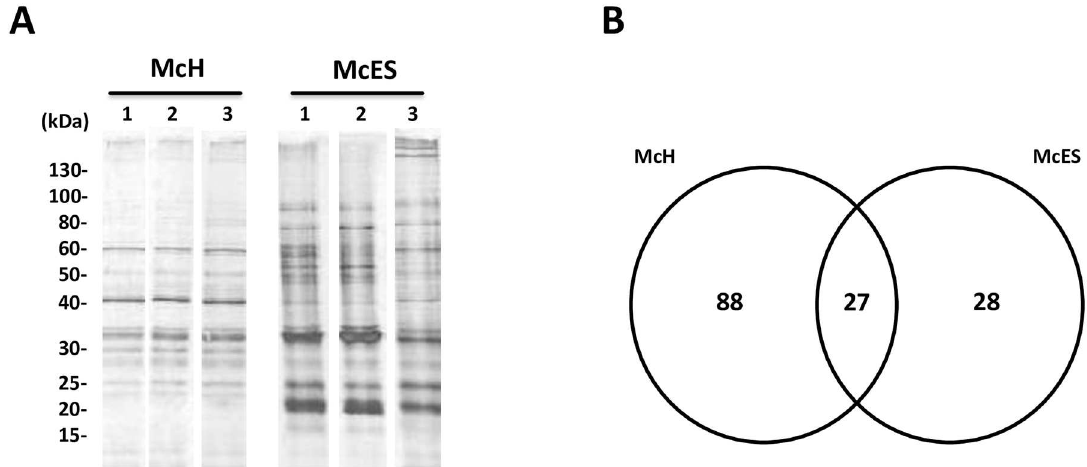
Fig 6. Comparison of McH and McES proteins. (A) One-dimensional SDS-PAGE of M . corti somatic homogenate (McH) and excretory-secretory products (McES). Three independents batches of McH and McES were compared by 1D SDS-PAGE; each lane was loadedwith 0.5 μ g of protein. Molecularweights markers are indicated on the left. (B) Venn diagram of total proteins from McH vs. McES enumerating specific and shared identities.